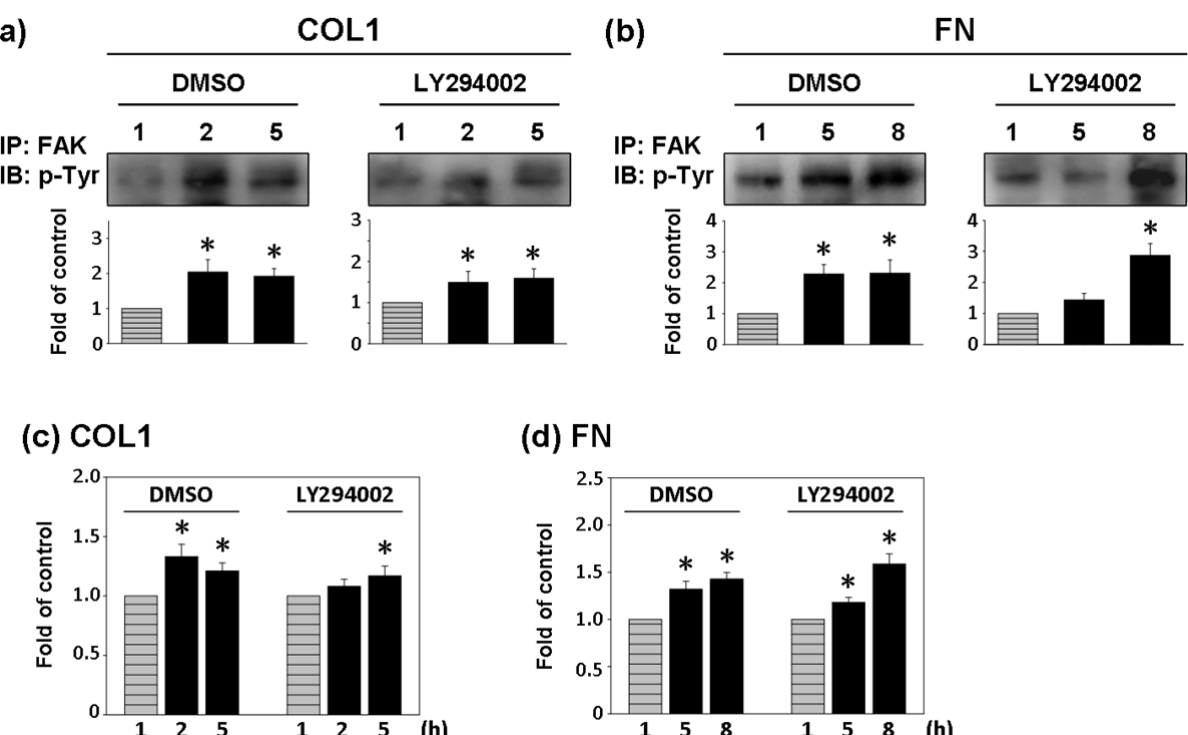
Figure 6. Effect of PI3K inhibitor, LY294002, on COL1 and FN-mediated phosphorylation of FAK and cell adhesion strengthening. FAK phosphorylation and cell adhesion strengthening at first hour cultivation was used as control. ( a ) and ( b ) Cells were pretreated with DMSO or LY294002 for 1 h and then cultured on ( a ) COL1- or ( b ) FN-coated PDMS membranes in the presence of DMSO or LY294002 as times indicated. Cells were collected from indicated time points and lysed by lysis buffer and immunoprecipated with FAK antibody. Phosphorylated FAK level was presented as band densities (normalized to immunoprecipitated FAK protein level) relative to control. IP, immunoprecipitation; IB: Western immunoblotting. * p < 0.05 versus control (first hour). ( c ) and ( d ) Cells were pretreated with DMSO or LY294002 for 1 h and then cultured on ( c ) COL1- or ( d ) FN-coated PDMS membranes in the presence of DMSO or LY294002 as times indicated. Cell detachment force of indicated time points was detected by DEP force measurement system normalized to cell adhesion strengthening at first hour cultivation (which was assigned a value of 1 arbitrary unit). * p < 0.05 versus control (first